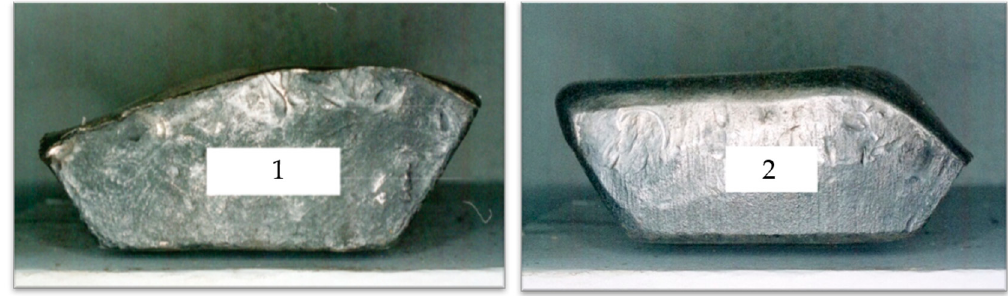
Figure 6. Wedges corresponding to alloys 1 and 2.